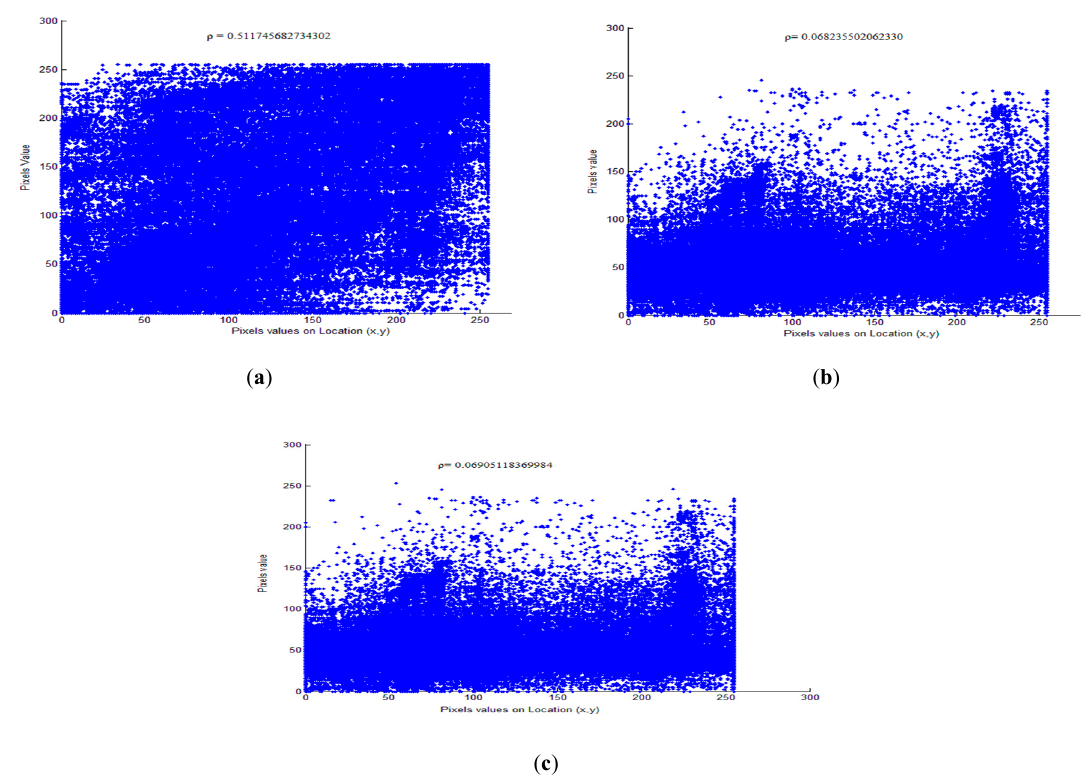
Figure 12. Comparative pixels correlation coefficient of plaintext and encrypted mobile video sequence. ( a ) XOR; ( b ) AES-CFB; ( c ) EXPer.